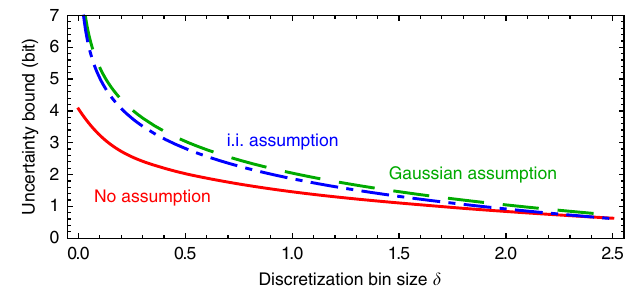
Fig. 4 Uncertainty bounds. Uncertainty bound without assumptions (red, solid), under the identical and independent (i.i.) assumption over m E = 10 signals (blue, dashed-dotted) and under Gaussian assumptions (green, long-dashed) depending on the binning size δ . n = 10 8 , ϵ A = 10 − 7 . We see that the best bound is obtained under the Gaussian assumption.